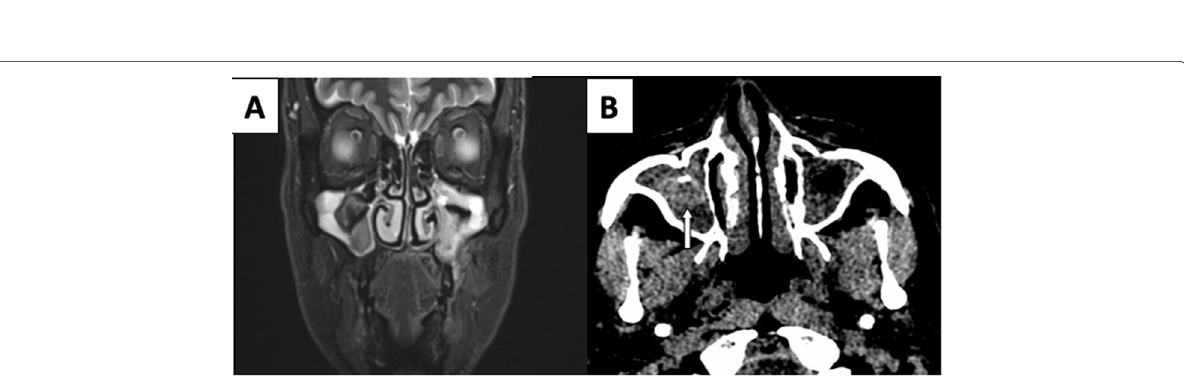
Fig. 6 This case highlights IFRS on the left side. A Coronal fat sat T2W image showing involvement of left half of maxillary alveolar process and adjacent soft tissue and non-invasive fungal ball with calcification in right maxillary sinus (white solid arrow in B ). Axial